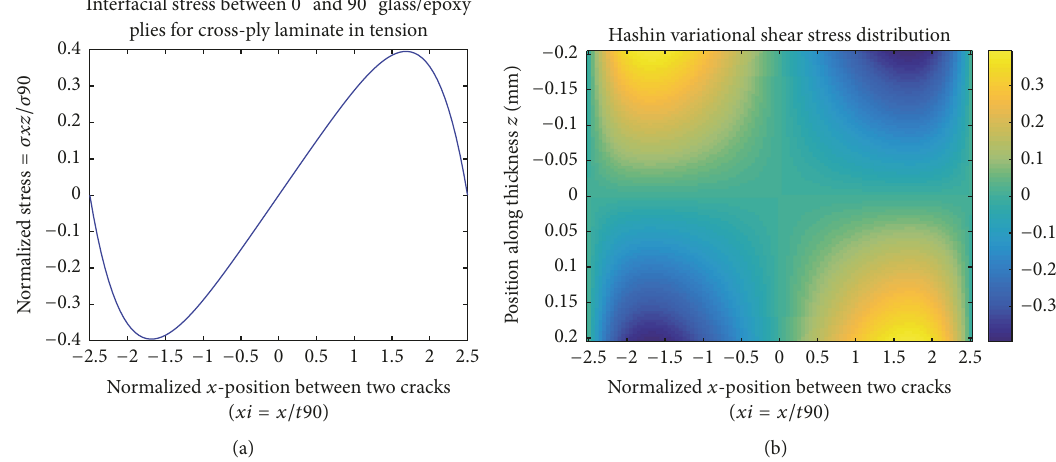
Figure 7: (a) Interfacial shear stress variation along the interface between 0 and 90 plies of a glass fiber/epoxy cross-ply [0/90] s laminate under longitudinal stress and (b) shear stress distribution for a glass fiber/epoxy cross-ply laminate under longitudinal stress, both using variational method [14].